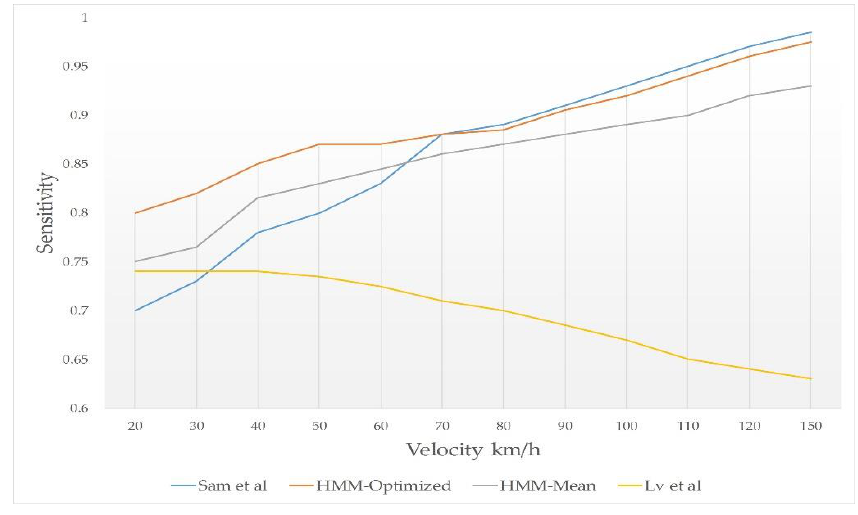
Figure 7. Velocity versus Sensitivity.